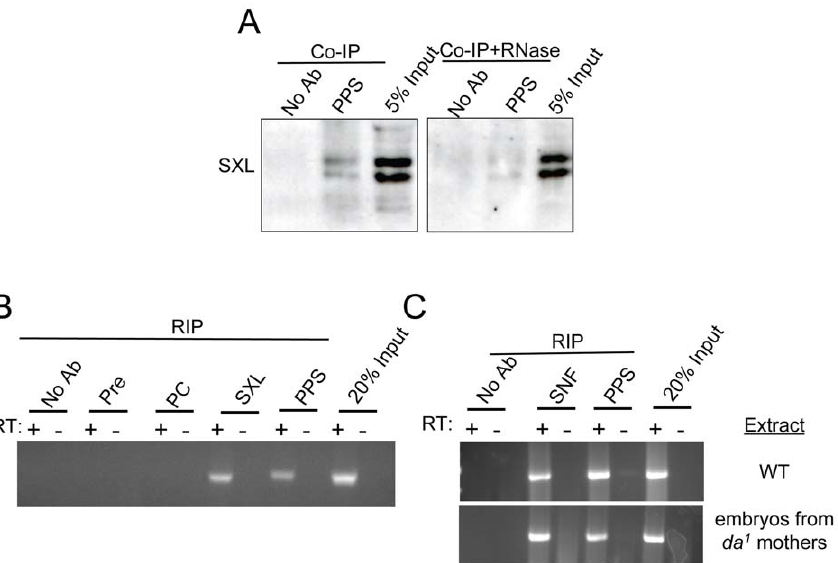
Figure 5. PPS associates with the SXL protein and the Sxl pre–mRNA. (A) PPS interacts with SXL in a RNA-dependent manner. Western blots of PPS immunoprecipitations (Co-IP) in nuclear extracts made from embryos probed with an antibody against SXL. The RNase sensitivity of this association was tested by pretreating the extract with a combination of RNase A and RNase T1. (B,C) PPS associates with the unspliced Sxl pre-mRNA in a SXL-independent manner. RNA-immunoprecipitation assays (RIP) were carried out in nuclear extracts made from wild type embryos (WT), or embryos from da 1 /da 1 mothers. The presence of unspliced Sxl RNA in the IP pellet was detected by RT-PCR using an intron 3/exon 4 primer pair. Immunoprecipitations with SXL or SNF were included as positive controls. Negative controls included precipitations with no antibody, pre-immune serum and Polycomb (PC). The lanes marked input are controls in which the amount of extract corresponds to a percentage of the material used in each Co-IP